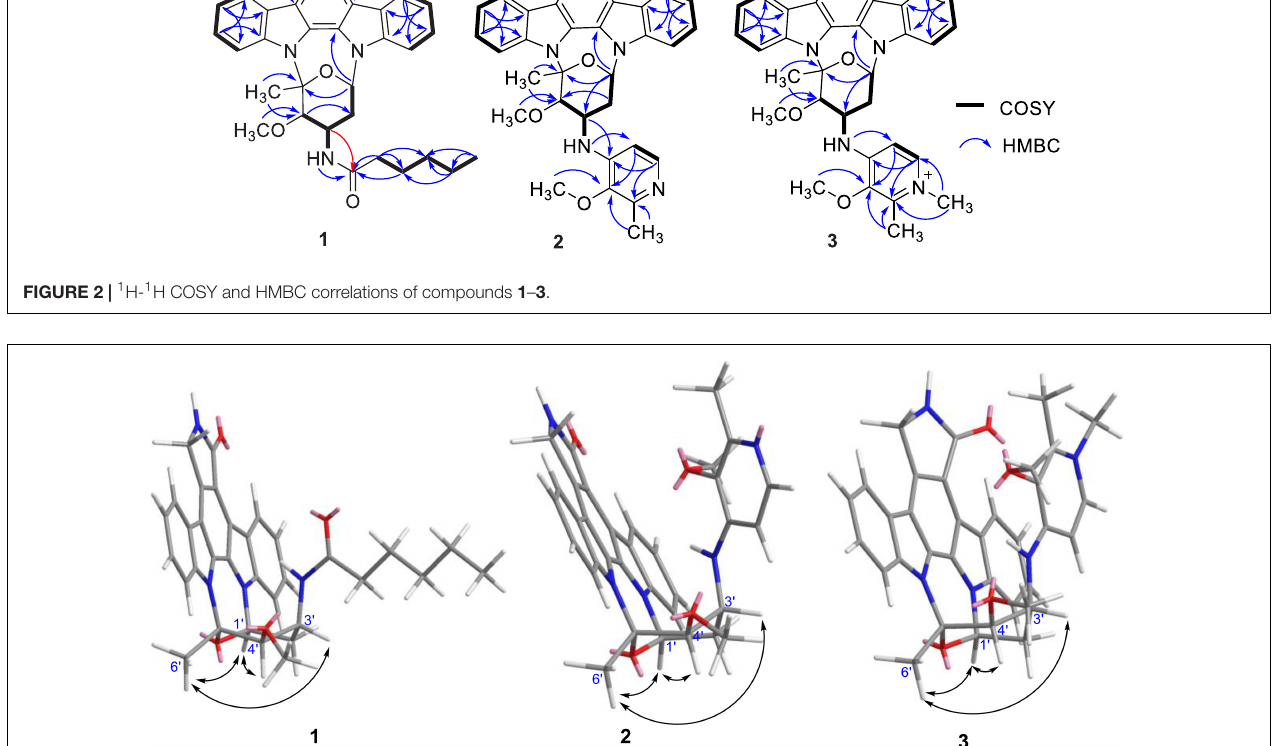
FIGURE 3 | Key NOESY correlations of compounds 1 – 3 .